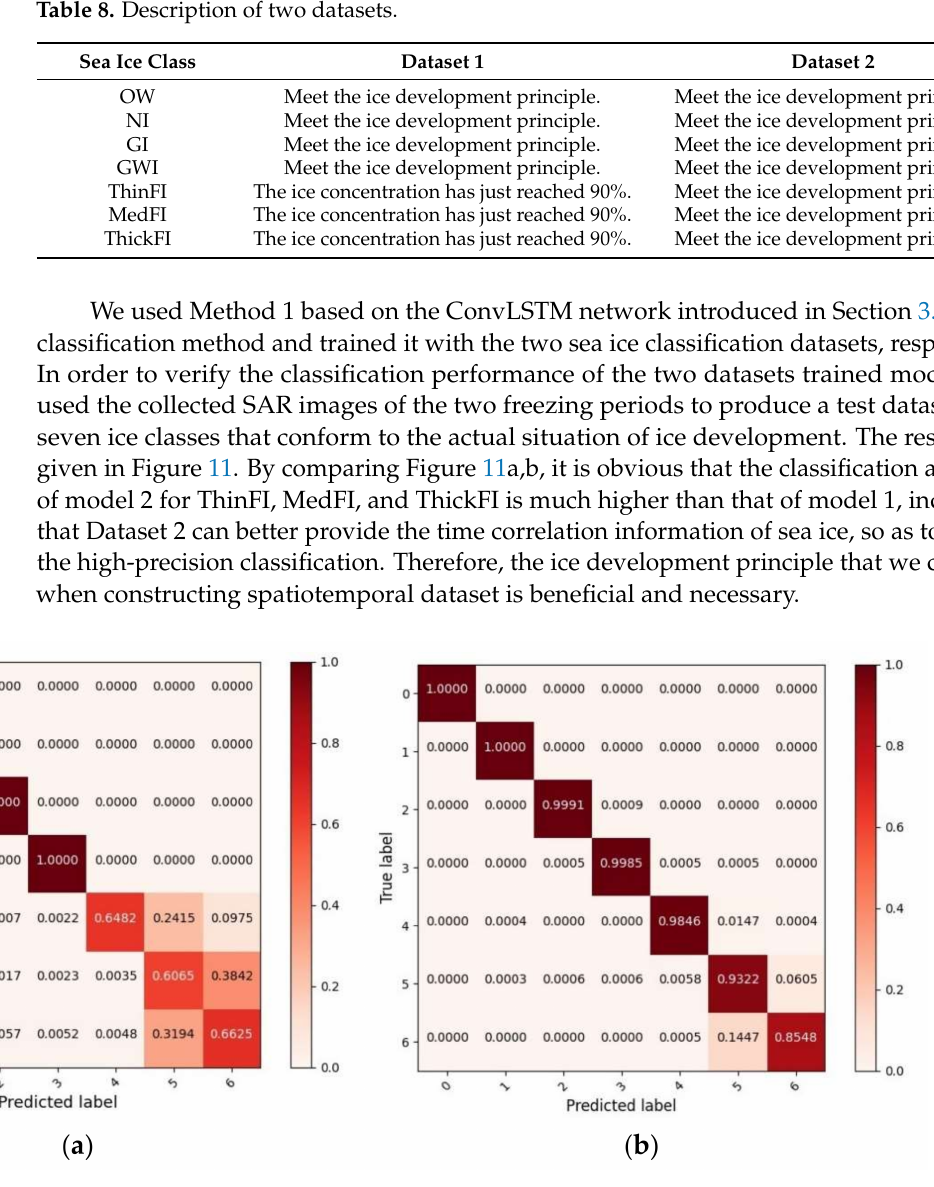
Figure 11. Confusion matrix of the classification results on the test dataset. ( a ) Model 1 trained by Dataset 1, ( b ) model 2 trained by Dataset